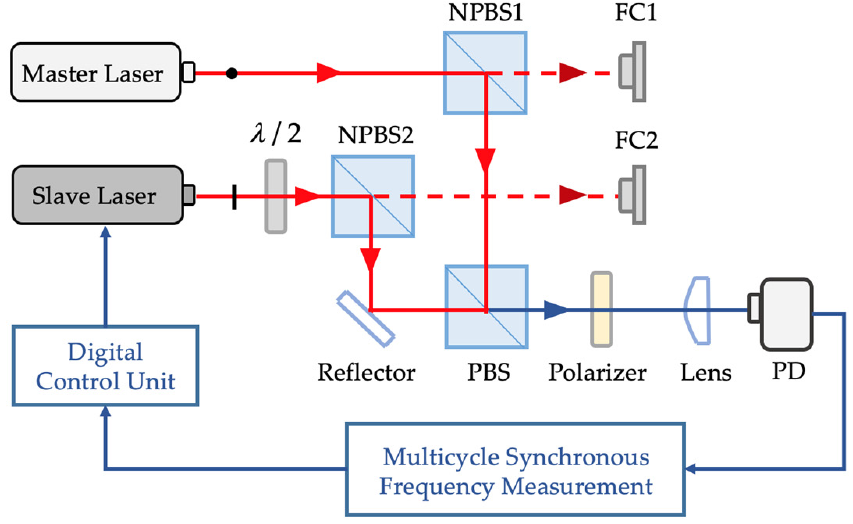
Figure 4. Experimental setup for the offset-locked dual-frequency laser source.